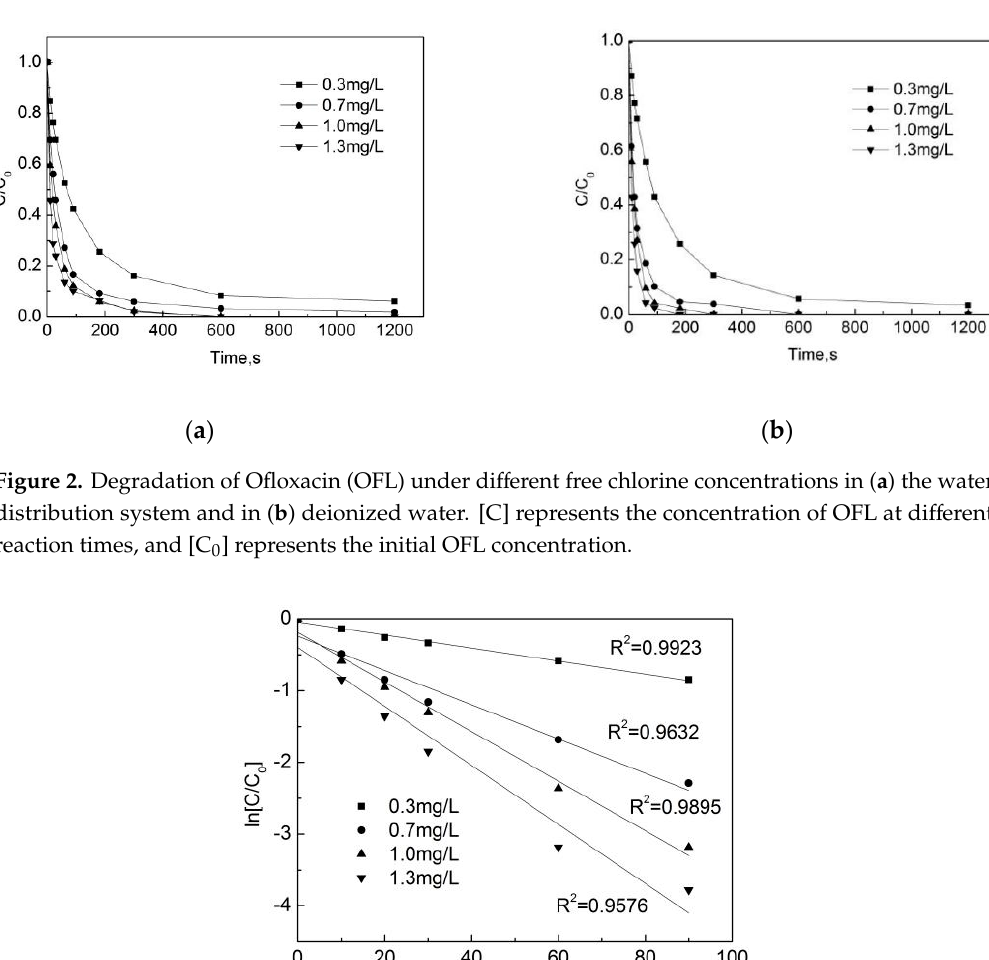
Figure 2. Degradation of Ofloxacin (OFL) under different free chlorine concentrations in ( a ) the water distribution system and in ( b ) deionized water. [C] represents the concentration of OFL at different reaction times, and [C 0 ] represents the initial OFL concentration.